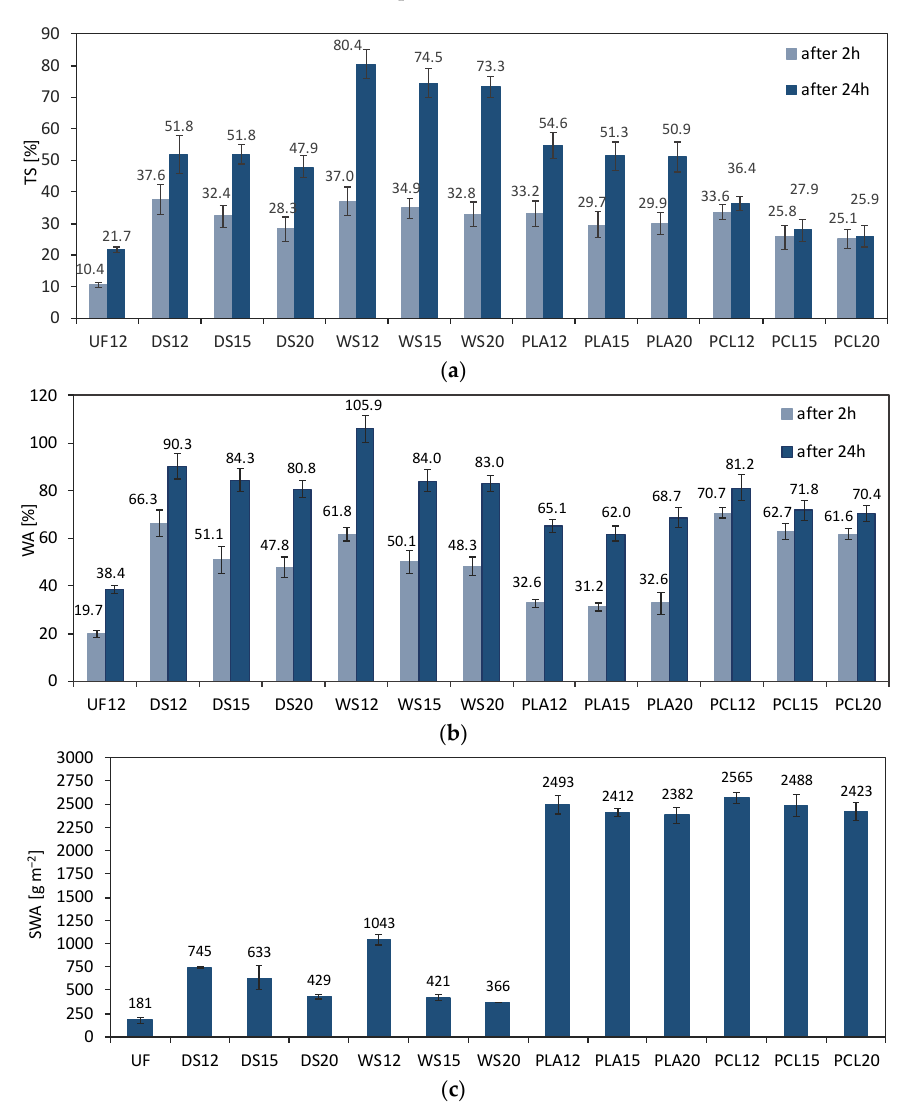
Figure 7. ( a ) Thickness swelling (TS), ( b ) water absorption (WA), and ( c ) surface water absorption (SWA) of tested HDF.